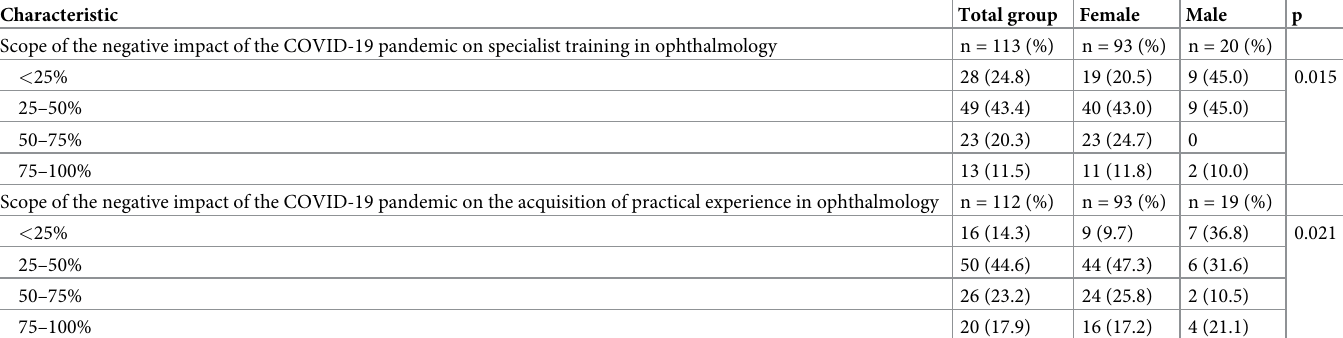
Table 4. Assessment of the negative impact of the COVID-19 pandemic on the implementation of the specialization program and the acquisition of practical skills according to sex.